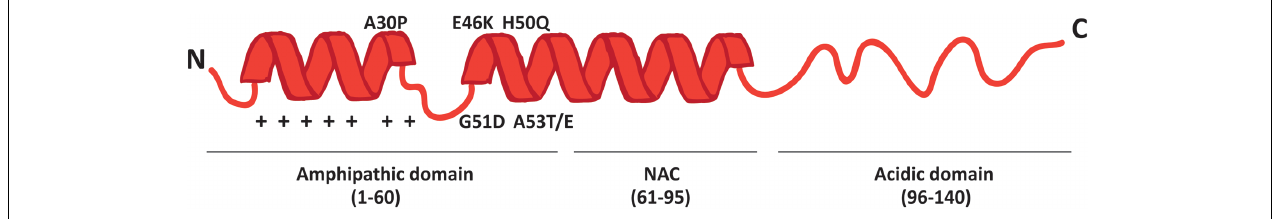
FIGURE 1 | Schematic representation of α -syn structure. The protein forms two alpha-helices when interacting with lipids and is composed of three distinct domains: the N-terminal amphipathic region, the non-amyloidogenic component (NAC) and the C-terminal acidic domain. The N-terminal domain drives α -syn to mitochondria thanks to the presence of seven positively charged lysine residues (indicated as +) and contains all the PD-related mutations.